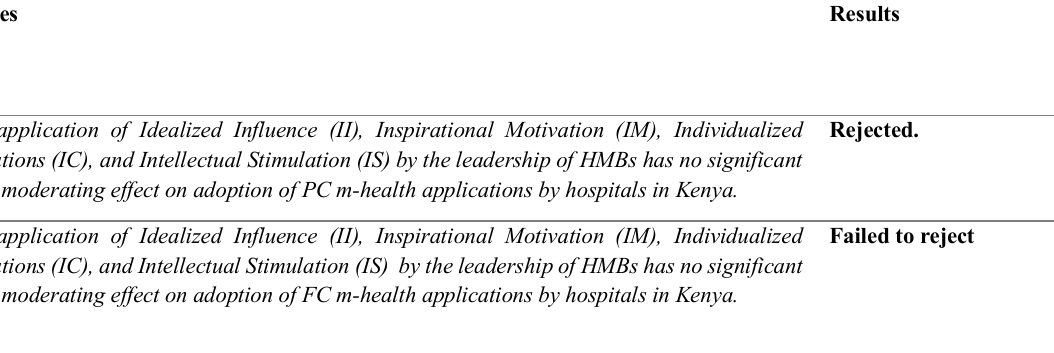
Table 10 below provides a summary of hypotheses tested: Table 10: Model result of hypotheses on moderating role of TLS by hospitals’ management boards in Kenya